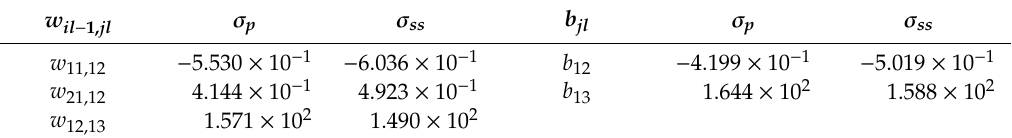
Table 4. Material constants (weights and biases) of the MLP approach for the σ p and σ ss description.